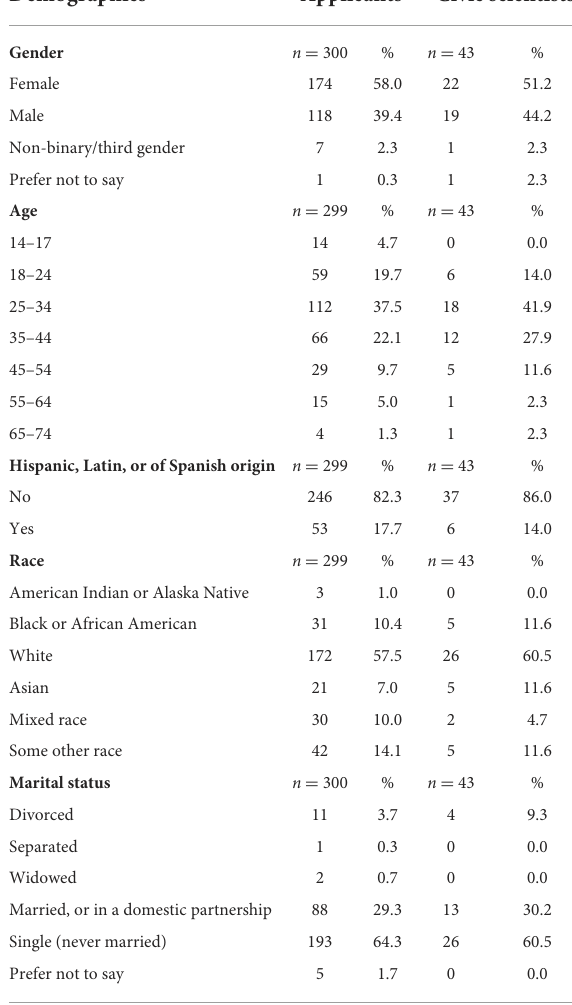
TABLE 2 Demographic characteristics of applicants and civic